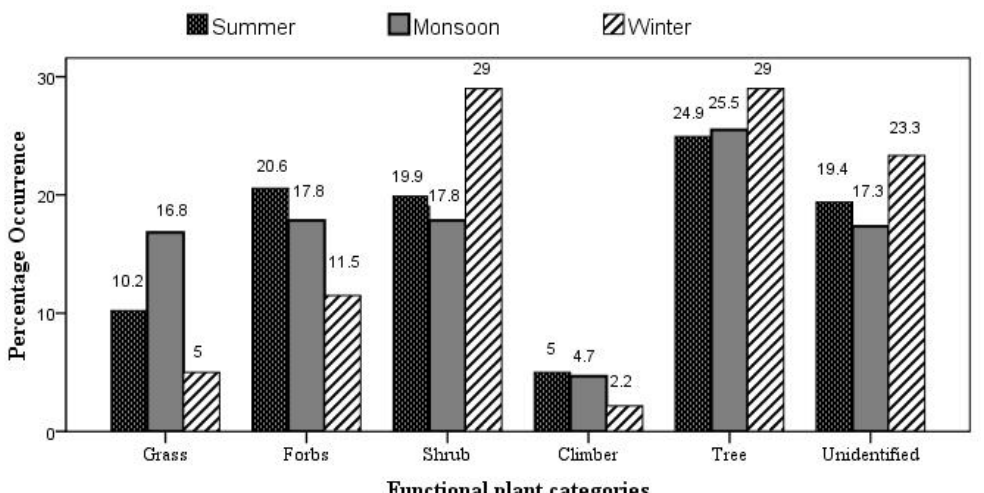
Figure 4. Percentage Occurrence of different functional plant types in the diet of Four-horned Antelope during the three seasons in Bardia National Park, Nepal